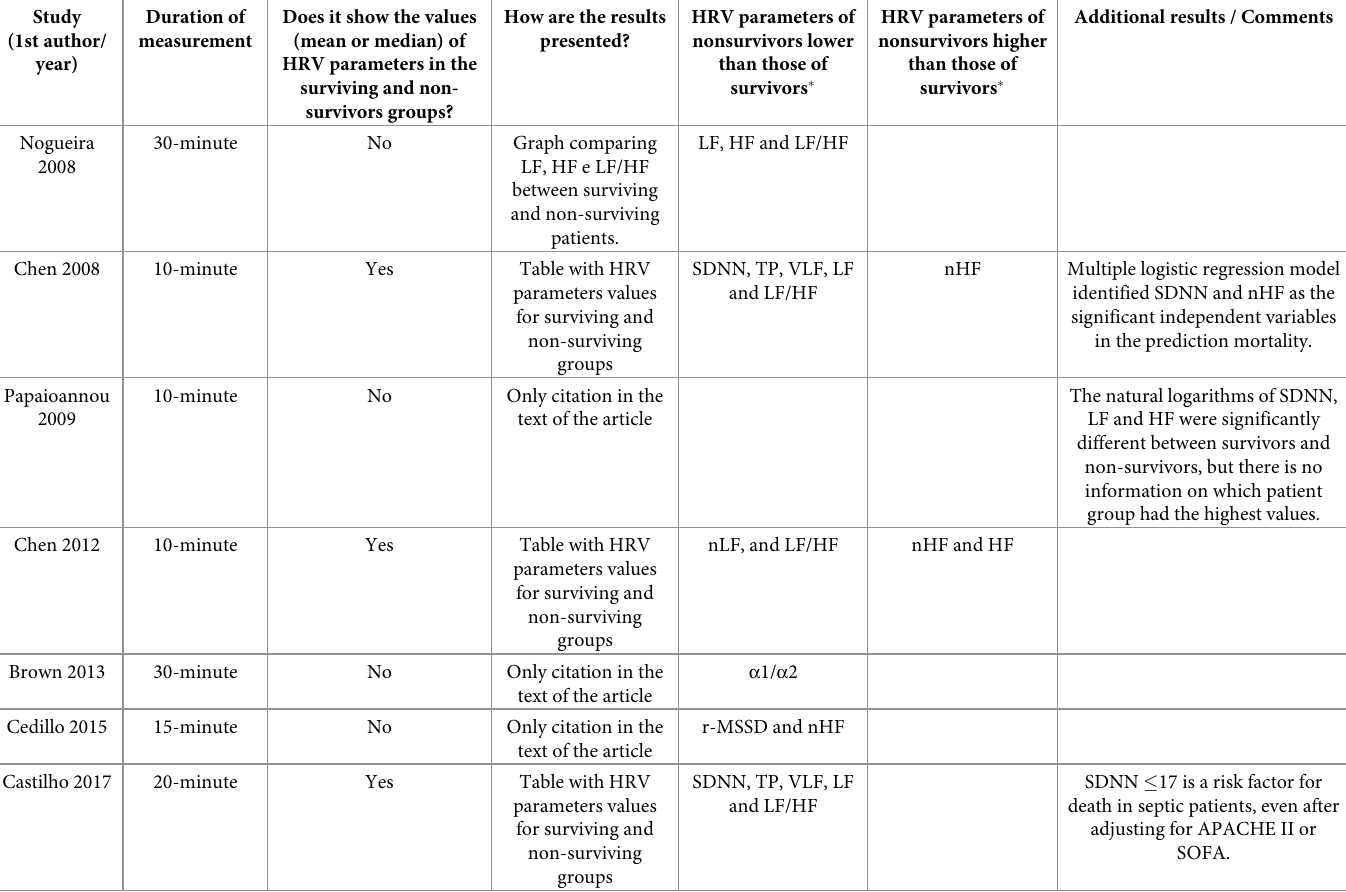
Table 4. Main results in short time record studies.